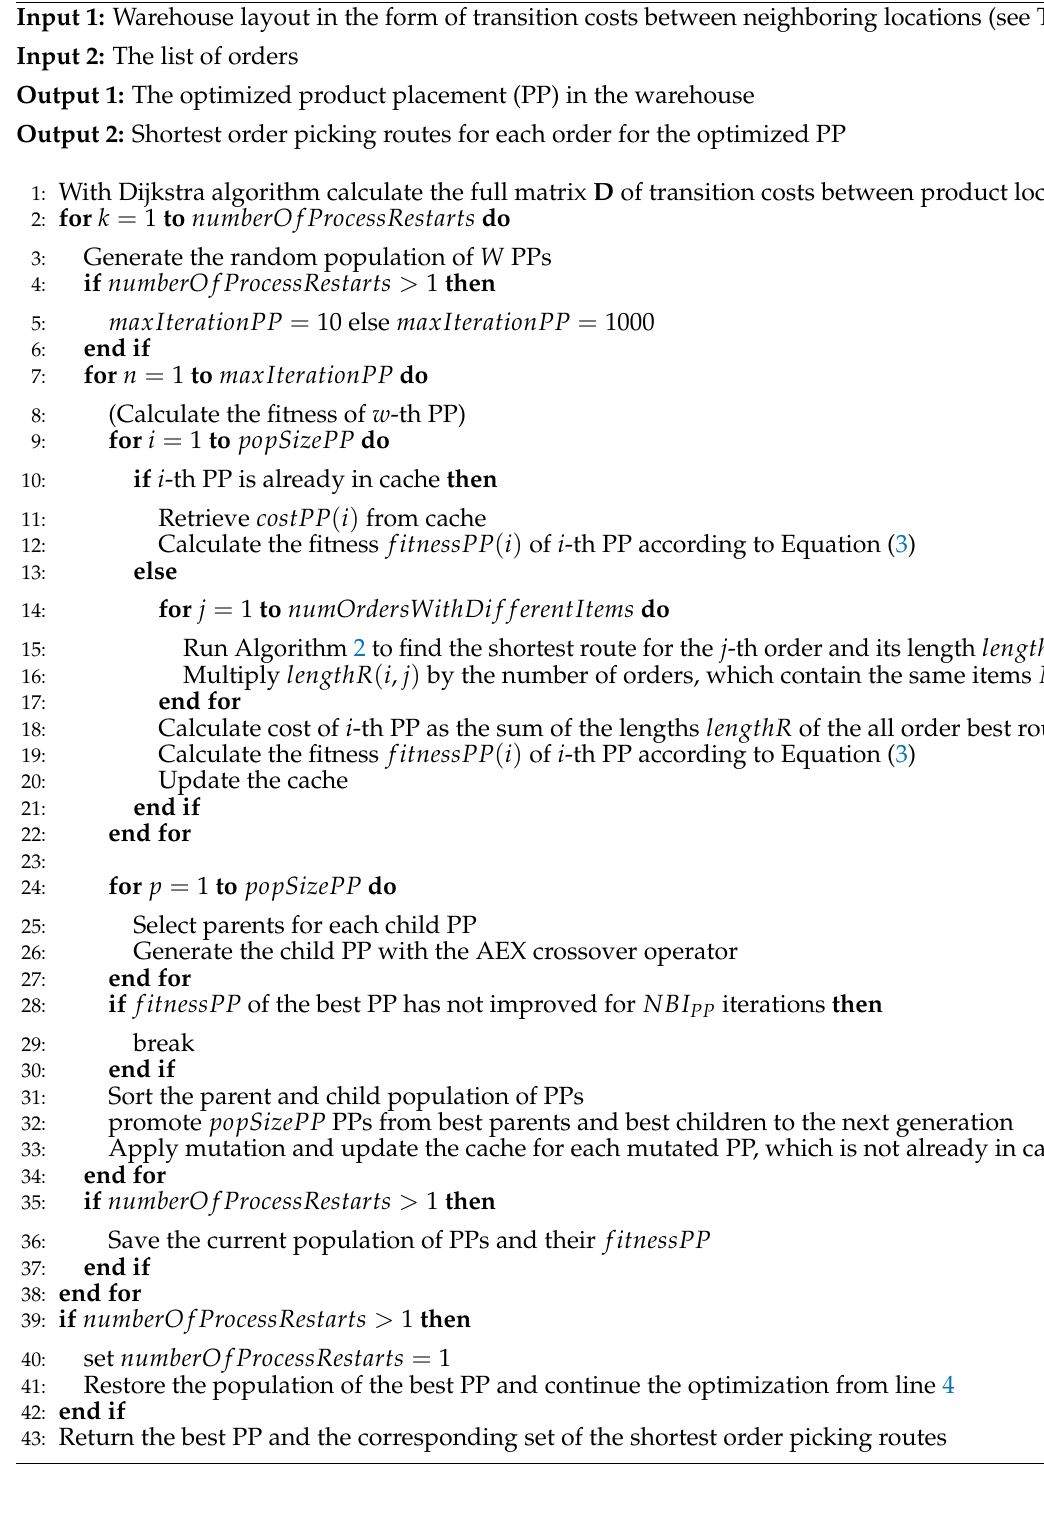
Algorithm 1 Product Placement (PP) Optimization